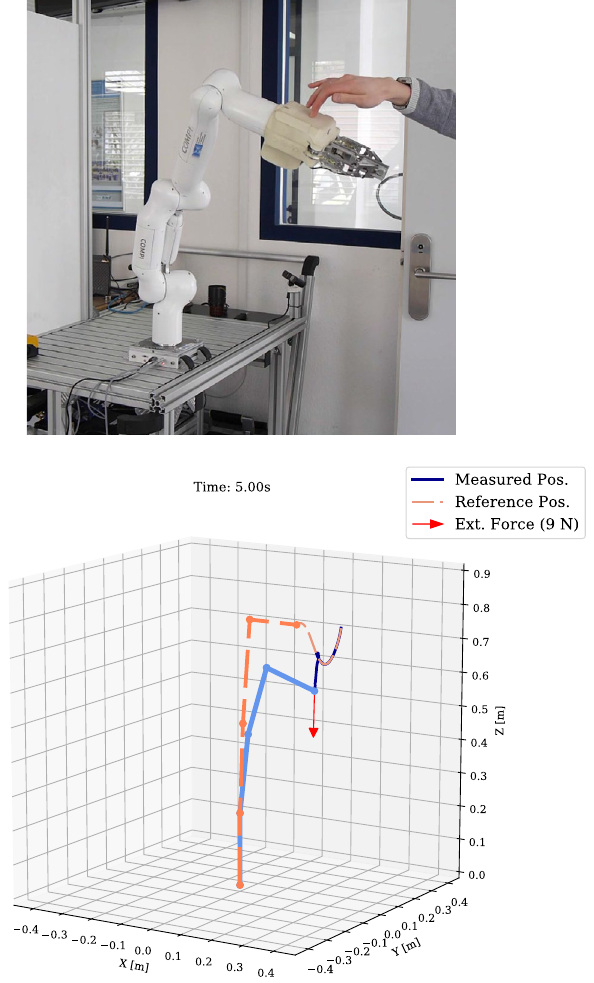
Fig. 14 Experimental setup (top) and deflection from reference path wrt. a disturbance force vector